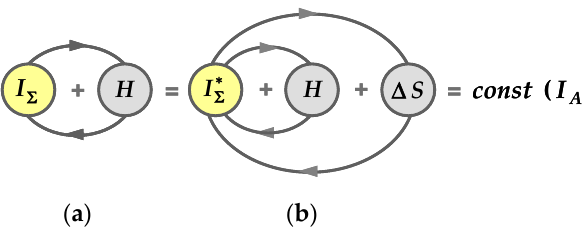
Figure 9. Graphic expression of the law of conservation and transformation of information: ( a ) Informationally closed system; ( b ) informationally open system.